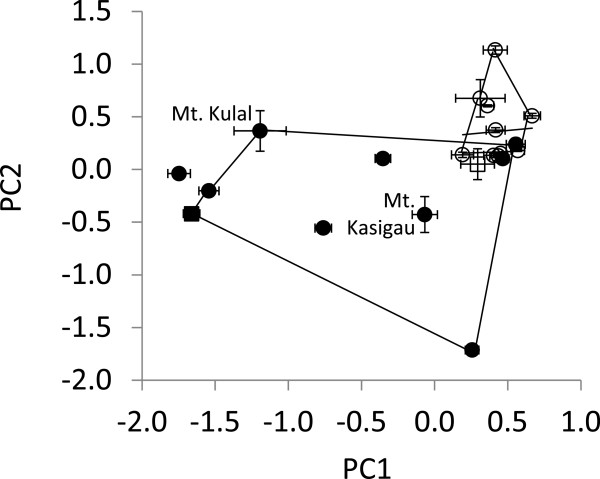
Average positions (error bars denote two standard errors) of
Z. abyssinicus
(parapatric and allopatric - open circles, sympatric - open square) and
Z. poliogaster
populations (parapatric and allopatric - black circles, sympatric - black square) within two dimensional acoustic PCA space (strongly driven by a variation of starting and lowest frequencies and of frequency range in the highland species
Z. poliogaster
, for summary of loadings see Table 1), convex hulls for both species exclude the respective sympatric populations.